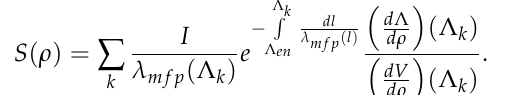
Figure 4. ( a ) An example of an injection line crossing the magnetic surface ρ = ρ ∗ four times; ( b ) Four branches of the function Λ ( ρ ) with alternating monotonicity shown by different colours corresponding to the colours of the segments of the injection line in ( a ).